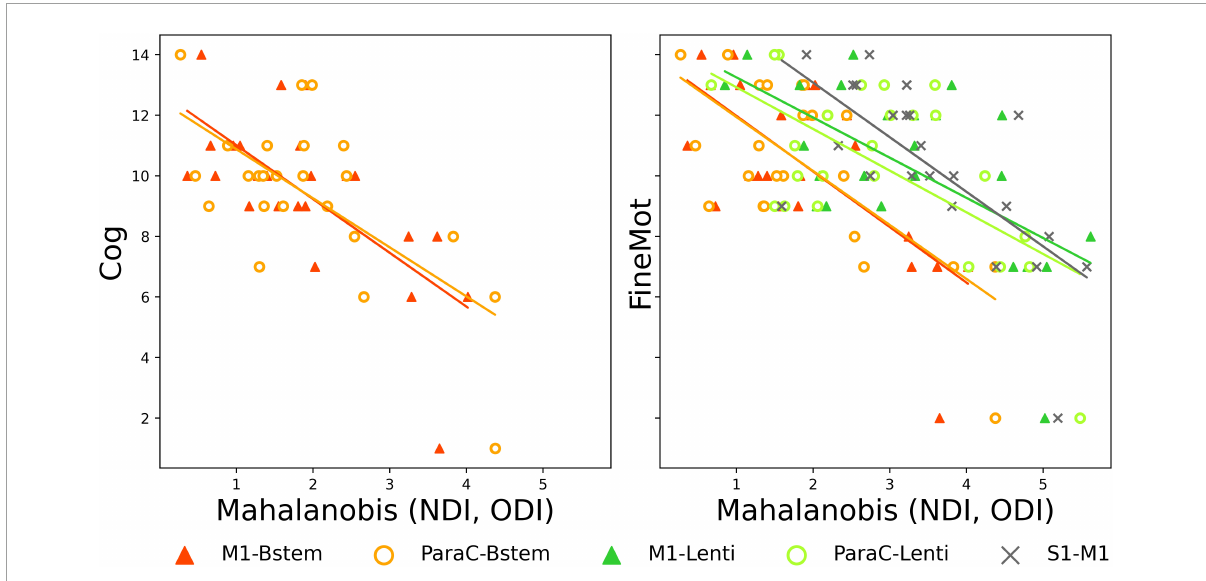
FIGURE5 Significant correlations between Mahalanobis distances and neurodevelopmental scores at 18mCA, for NODDI set. Scatter plots of the significant Pearson correlations between tract-specific maturational distance related to prematurity at TEA in PT EV group and BSID-III scores. Cog, cognitive; FineMot, fine motor scaled scores. Refer to Figure 1 legend for